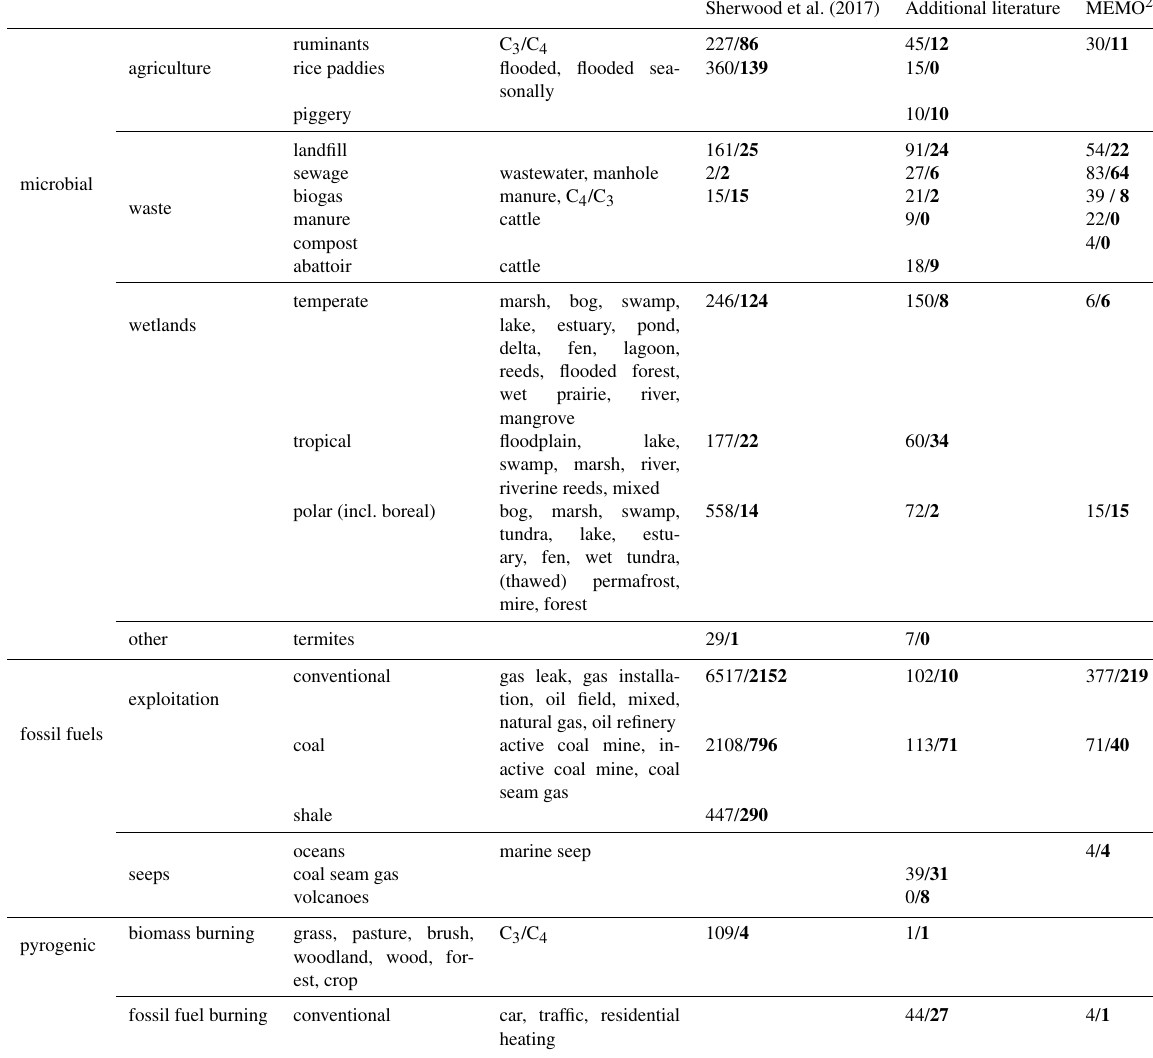
/ δ 2 H CH ) per source category in the updated CH 4 isotopic signature database. 4 4